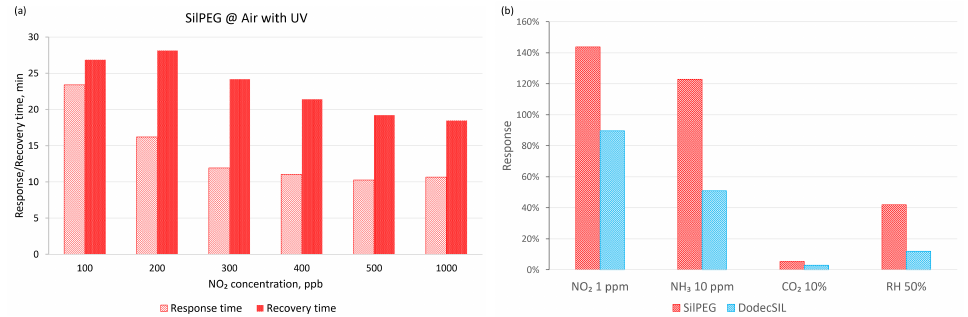
Figure 8. ( a ) Response and recovery times for SilPEG in air with UV; ( b ) selectivity of the polymers in air conditions with UV